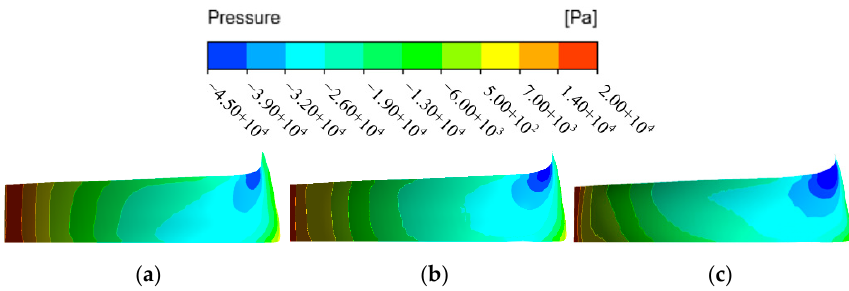
Figure 10. Static pressure at the suction surface for different ND C (the second interaction point between the straight line and the parabolic line at the crown): ( a ) ND C : =0.55; ( b ) ND C : =0.75; ( c ) ND C : =0.95.